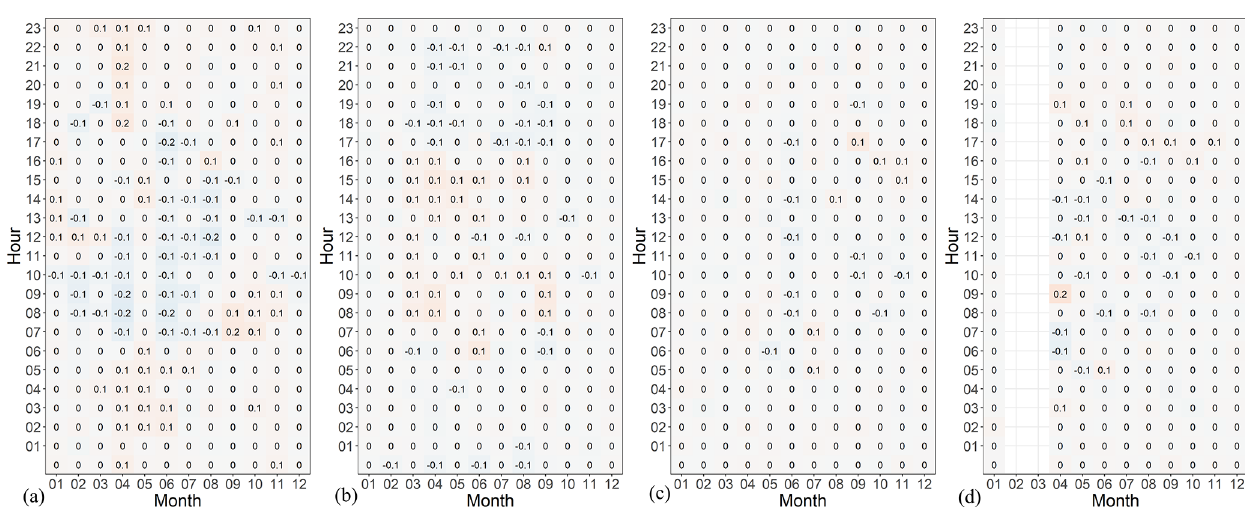
Figure 15. Same as Fig. 9 but for QC level 3.